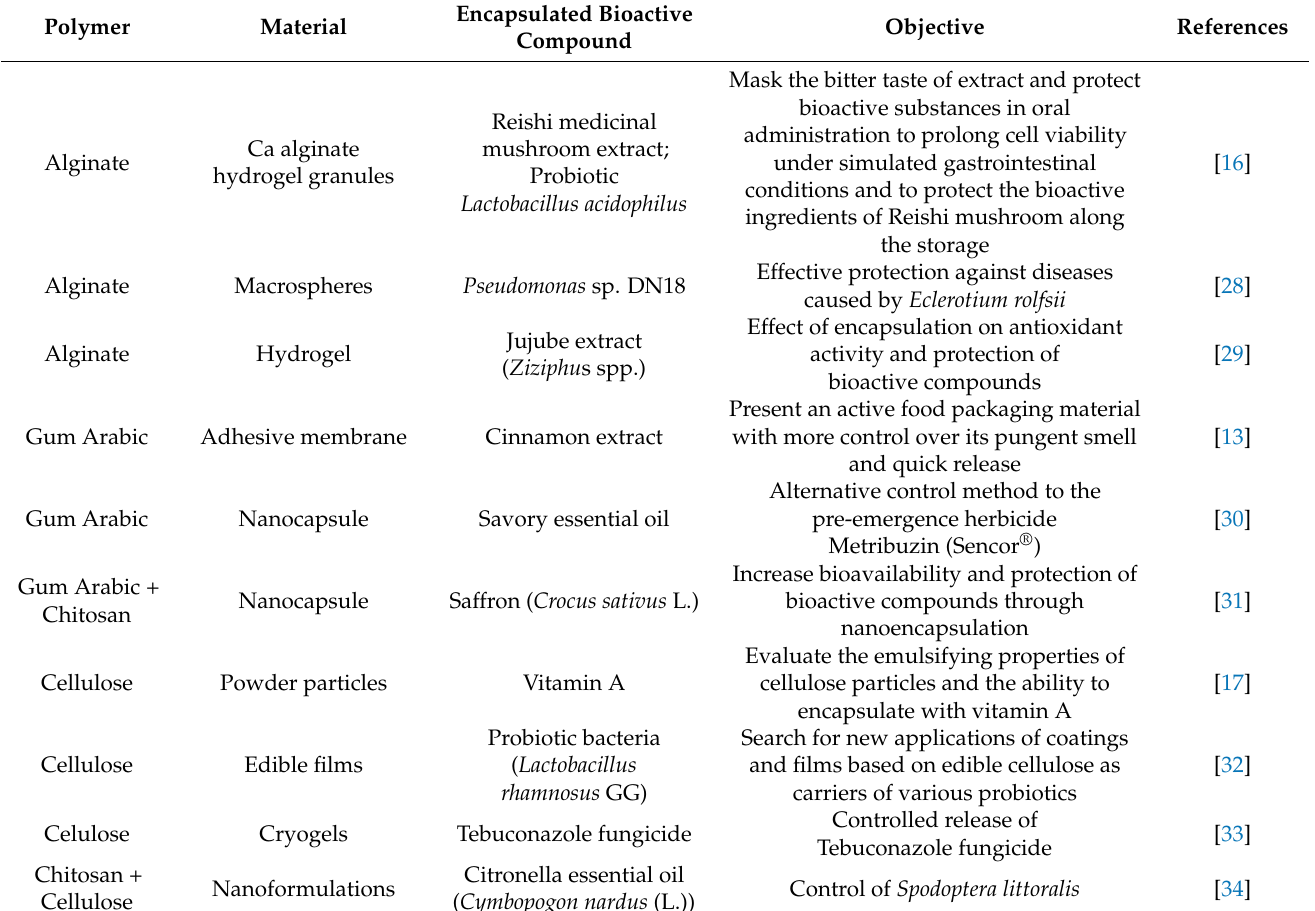
Table 1. Polymers used for encapsulation of bioactive compounds and the main objectives of the